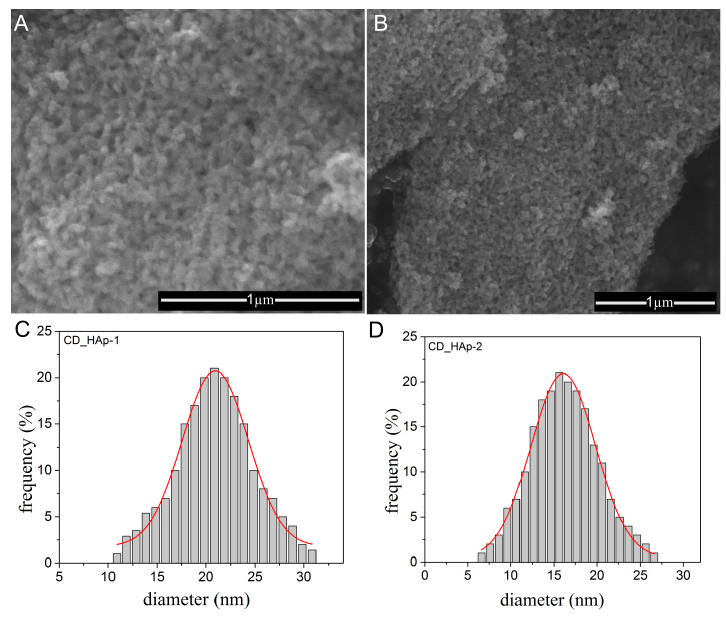
Figure 10. SEM images of: CD-HAp_1 ( A ); and CD-HAp_2 ( B ) samples before adsorption of lead ions.